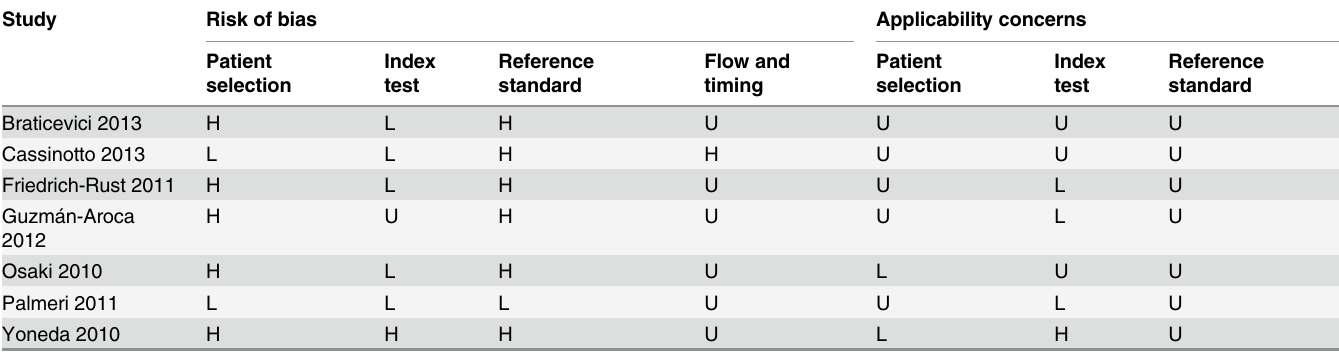
Table 2. Quality Assessment of Studies of Diagnostic Accuracy included in Systematic Review